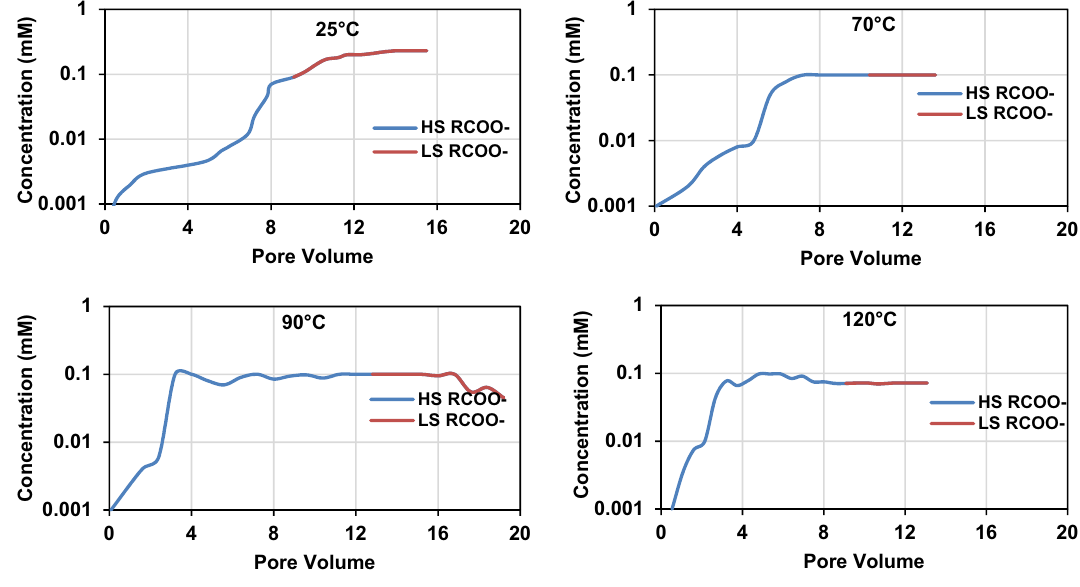
Fig. 8 Concentrations of RCOO − in first HS and LS water effluent for sandstone column#1 (sand + illite), at 25, 70, 90, and 120